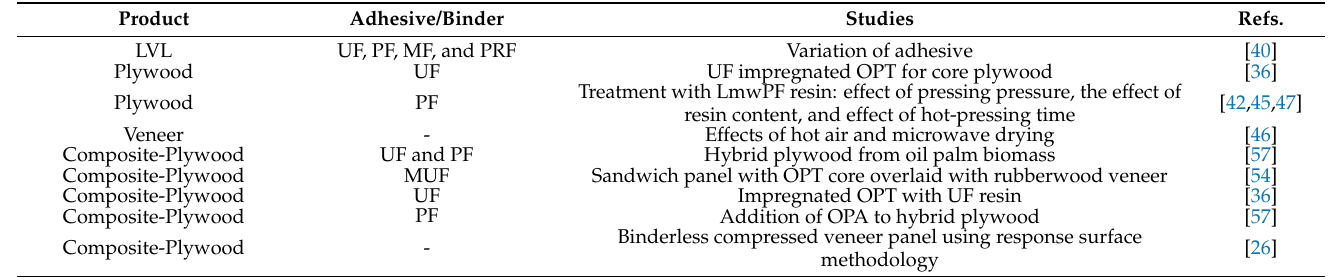
Table 3. Several modifications of OPT for LVL and plywood